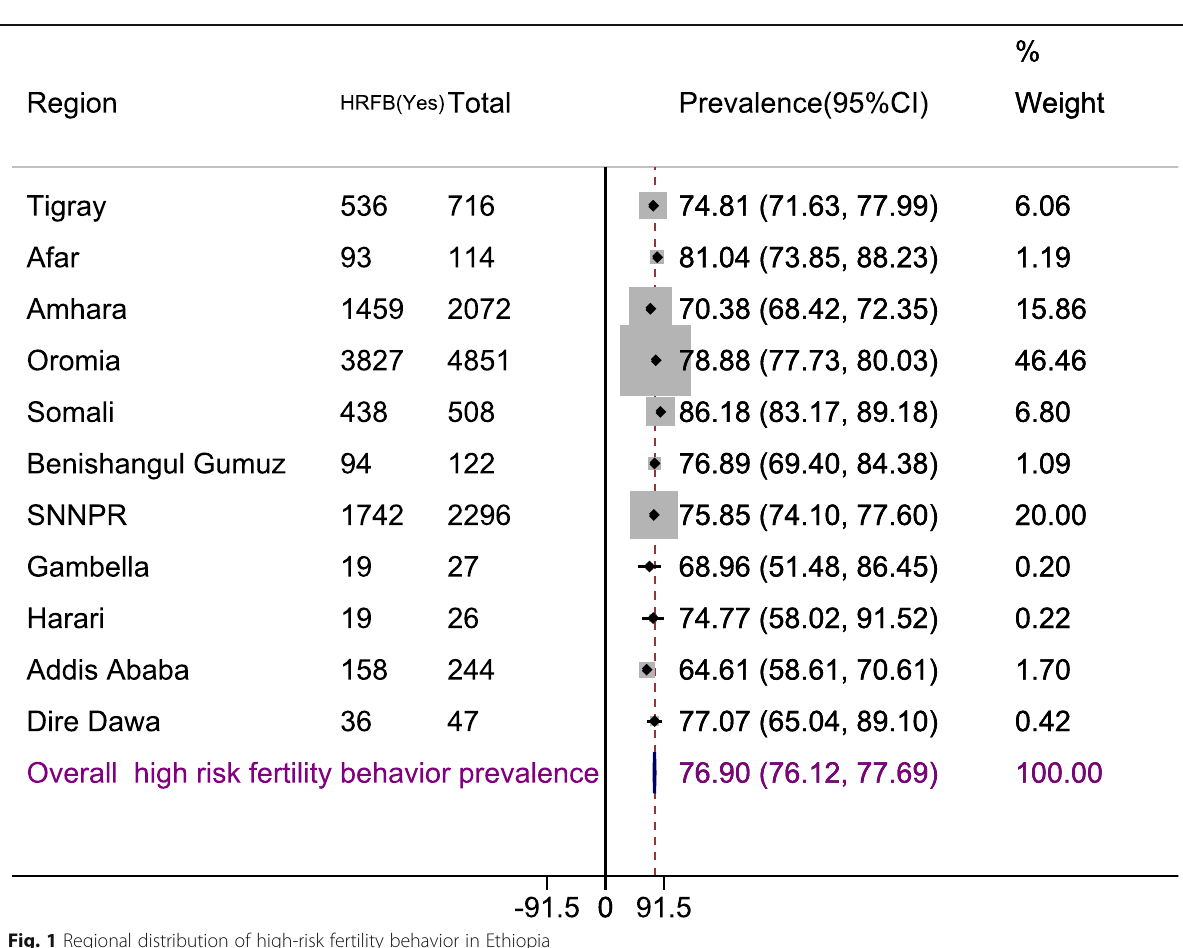
Fig. 1 Regional distribution of high-risk fertility behavior in